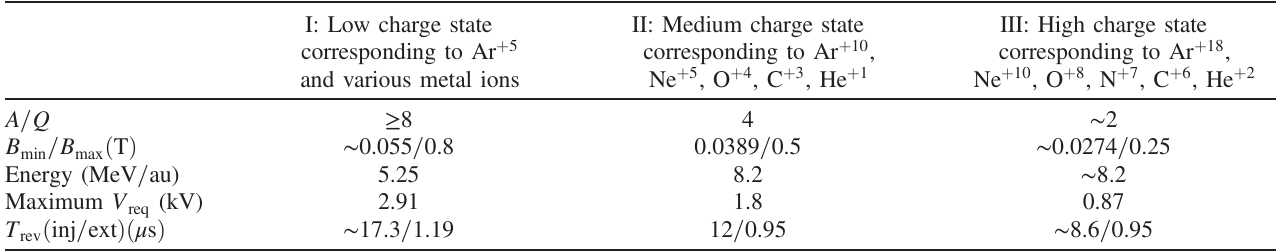
TABLE II. Classification of ion acceleration scenarios in KEK-DA and relevant parameters.